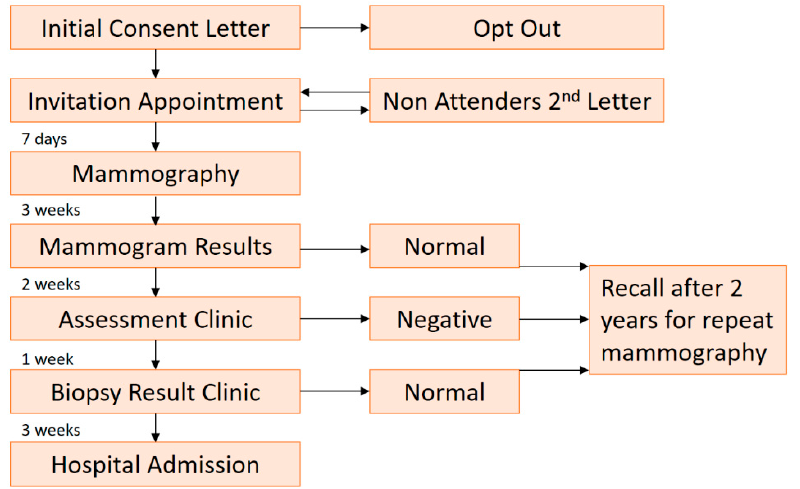
Figure 1. Screening process flow sheet and timescales for the BreastCheck screening program .